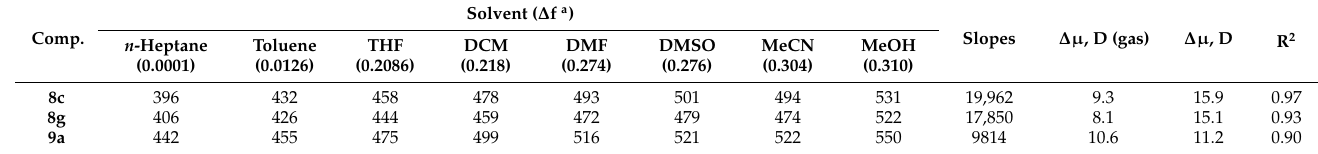
Table 2. Maximum emission wavelengths (nm) in different organic solvents and slopes were calcu- lated using the difference in the dipole moment of the excited state and the ground state using the CAM-B3LYP/6-31+G* basis in the gas and the experimental ∆ µ dipole moment of compounds 8c , 8g , and 9a